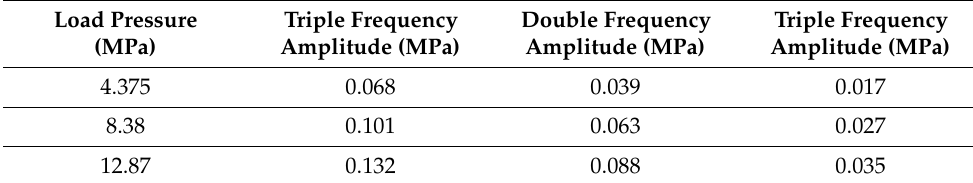
Table 3. Frequency doubling amplitude under different load pressures.